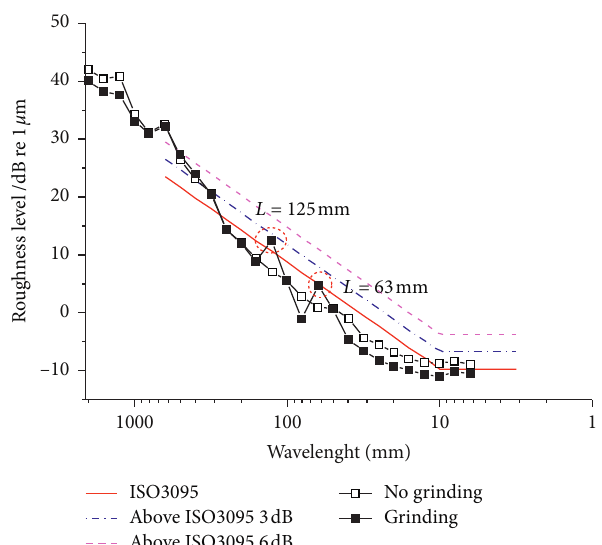
Figure 5: Comparison of roughness spectra in nonground and ground parts of the same rail.